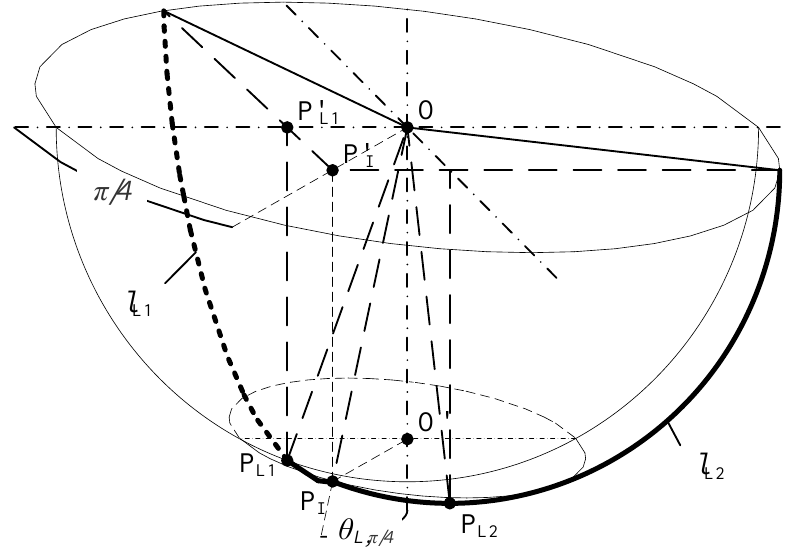
Figure A6. Ω L geometric sketch 1.